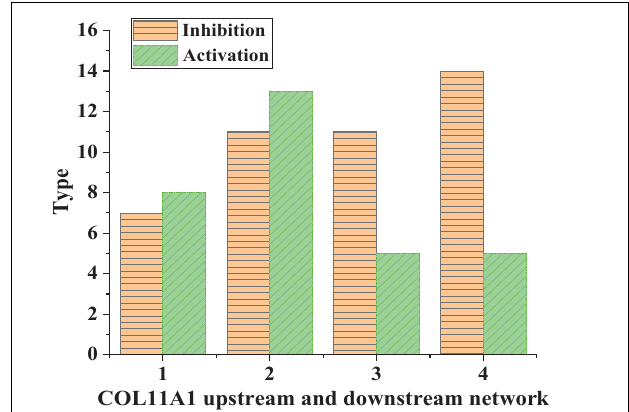
FIGURE 3 | COL11A1 upstream and downstream network signal transduction in different tissues (1 and 3: normal human tissue; 2 and 4: lung cancer tissue).